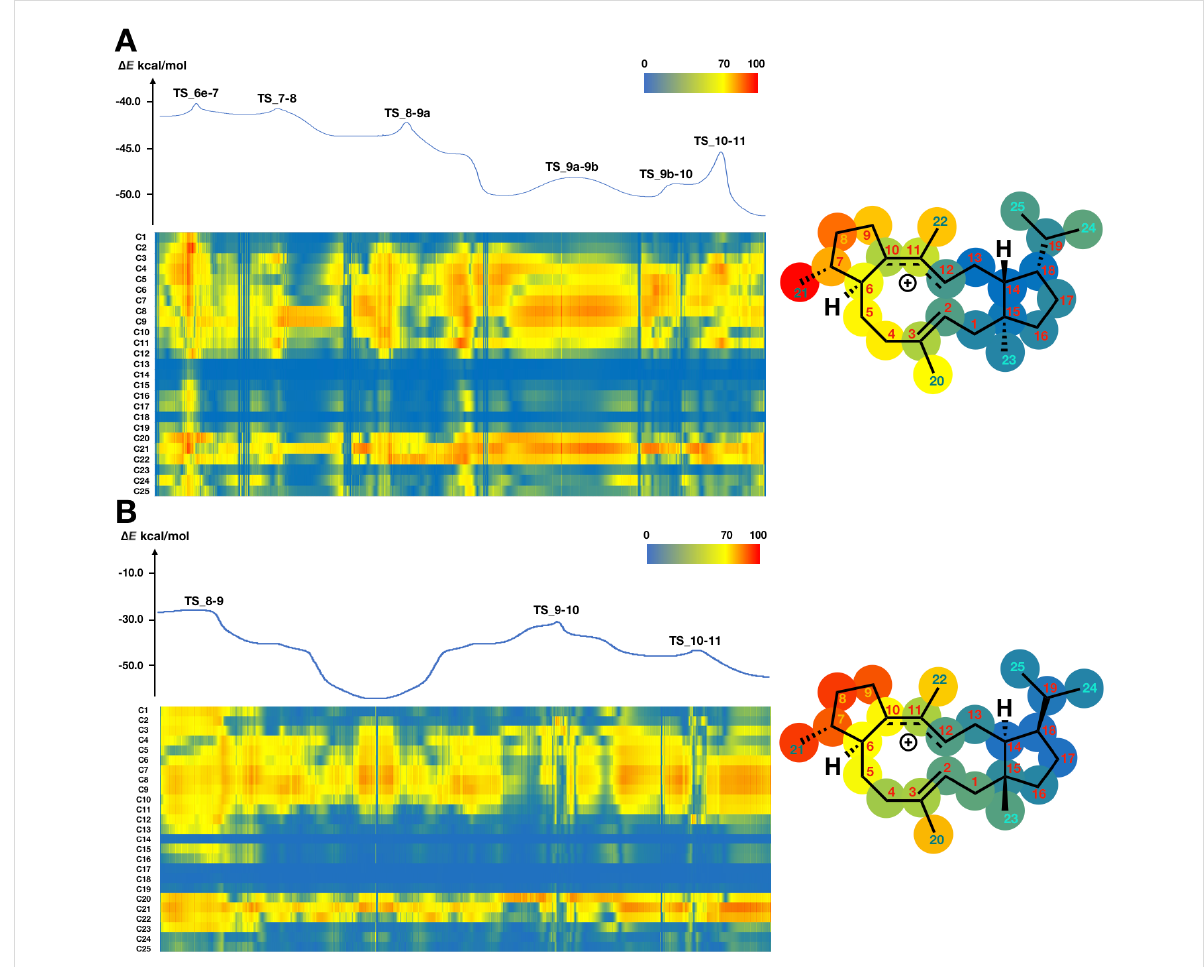
Figure 3: Energy diagram and heat map analysis of ring rearrangement (A) IM6e–IM11 in quiannulatene biosynthesis. (B) IM8–IM11 in sesterfisherol biosynthesis. An energy diagram and a heat map of inherent mobility are shown. All energies are shown in kcal/mol. The Y axis shows the carbon number and the X axis shows the coordinate in the heat map. The right structural heat map shows the total mobility. Red means high mobility, yellow means moderate mobility, and blue means static. TS: transition